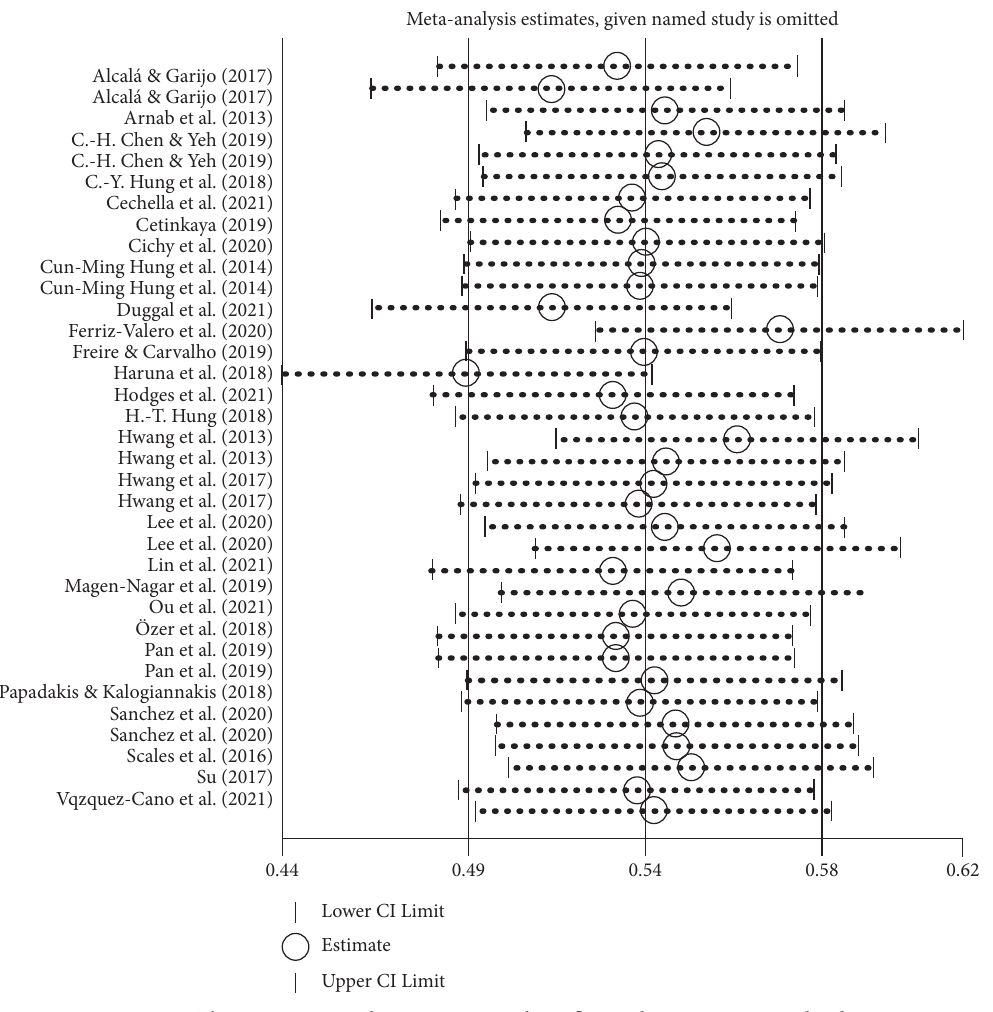
Figure 7: The sensitivity analysis examining the influential components in the data.